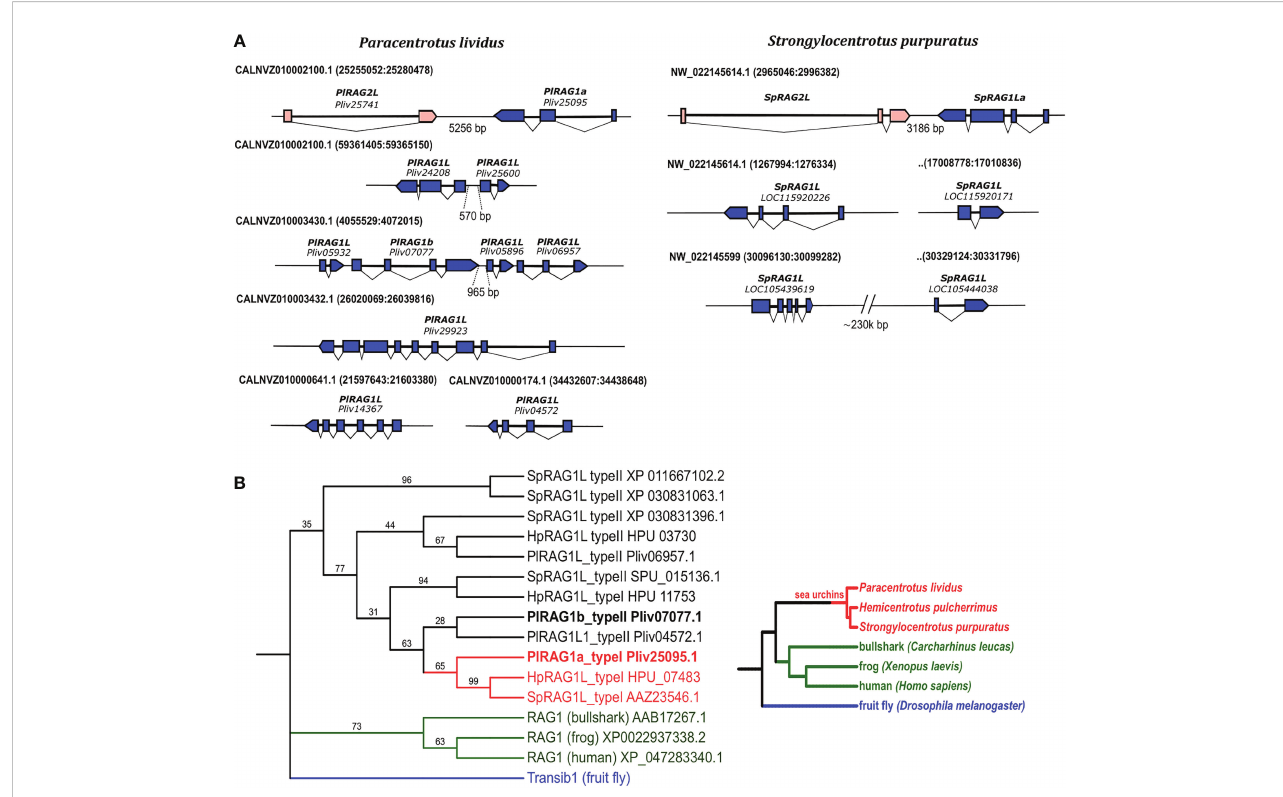
FIGURE 1 Genomic organization and phylogenetic relationships among echinoid RAG1L sequences. (A) . annotated RAGL genes in the genomes of P. lividus and S. purpuratus . (B) . phylogenetic relationships among echinoid RAG1L sequences. The phylogeny was made using transcribed sequences, based on maximum likelihood with Whelan and Goldman (WAG) model with consensus tree inferred from 500 bootstrap replicates. Drosophila melanogaster Transib autonomous protein was chosen as the outgroup (repbase https://www.girinst.org/server/RepBase/index.php accessed on July 2022). A corresponding guideline phylogeny of species is presented on the right to the phylogenetic relation of RAG1L translated protein